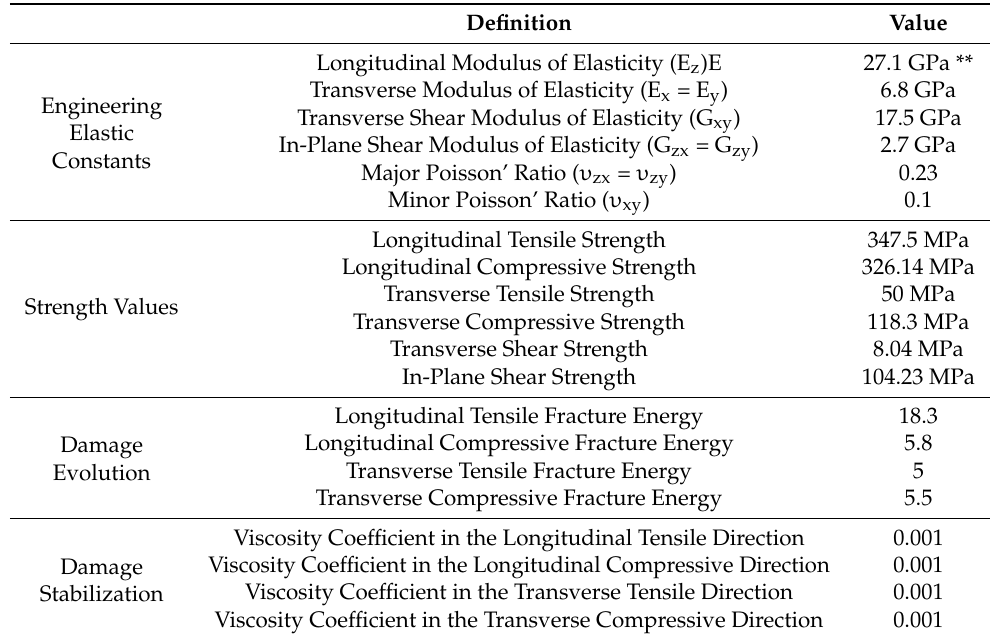
Figure 14. Stress-strain relationship of steel I-beam, rebars, and stirrups. Figure 14. Stress ‐ strain relationship of steel I ‐ beam, rebars, and stirrups. Table 9. GFRP materials properties and progressive damage parameters input in Table 9. GFRP materials properties and progressive damage parameters input in ABAQUS.